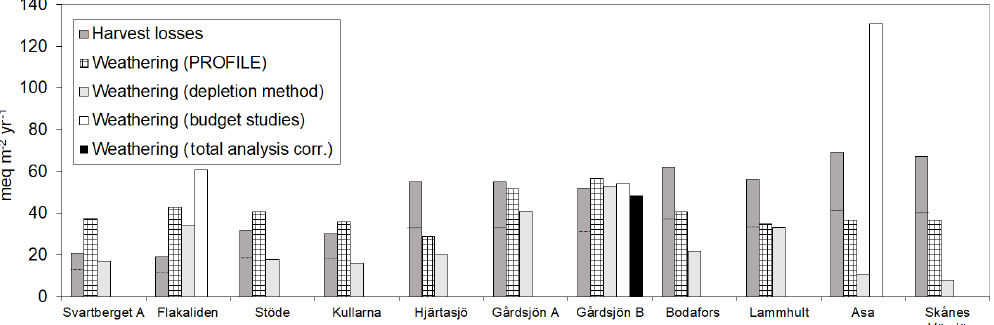
Figure 6. Weathering rates of base cations calculated with different methods on spruce sites, compared with harvest losses of base cations at whole-tree harvesting (100% of the stems and 60% of the branches harvested, and 75% of the needles on the branches removed). The horizontal dashed lines in the harvesting bars show the levels for stem-only harvesting. The sites are ordered from north to